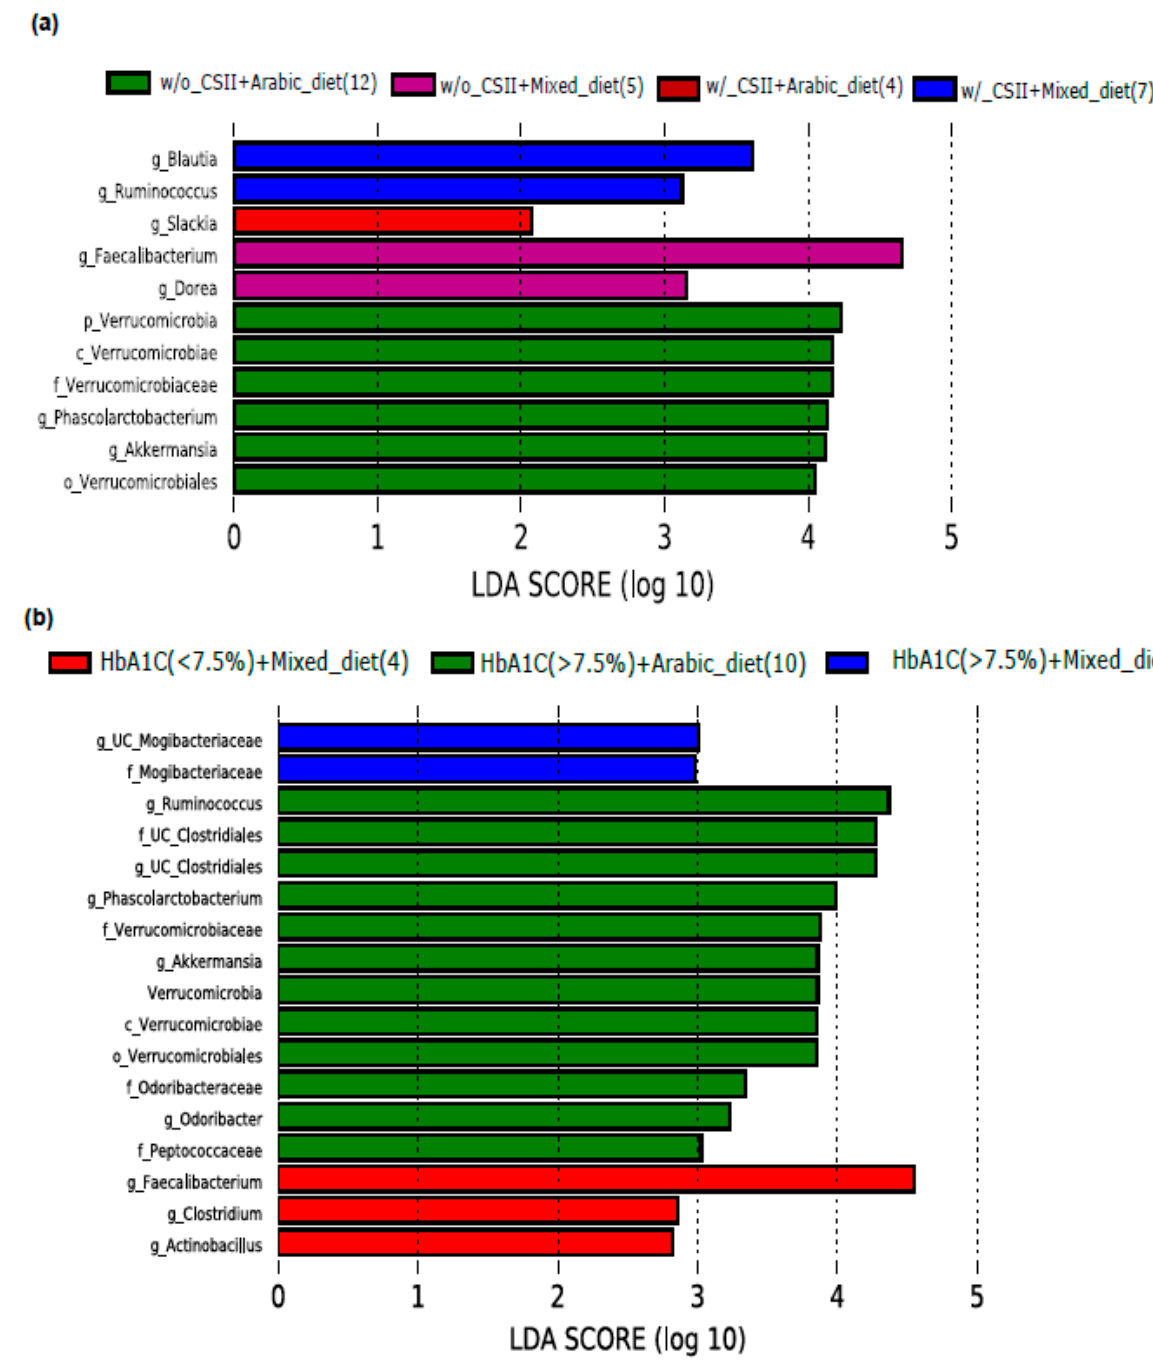
Figure 3. Impact of CSII therapy and diet on genus Akkermansia in poorly controlled T1DM subjects. ( a , b ) LEfSe analysis revealed that Akkermansia was enriched only in the subjects without CSII therapy treatment and poor glycemic control who consumed the Arabic diet. LDA cutoff value >2.0; Note: g_UC, genus_unclassified; w/_CSII, with CSII therapy; w/o_CSII, without CSII therapy.